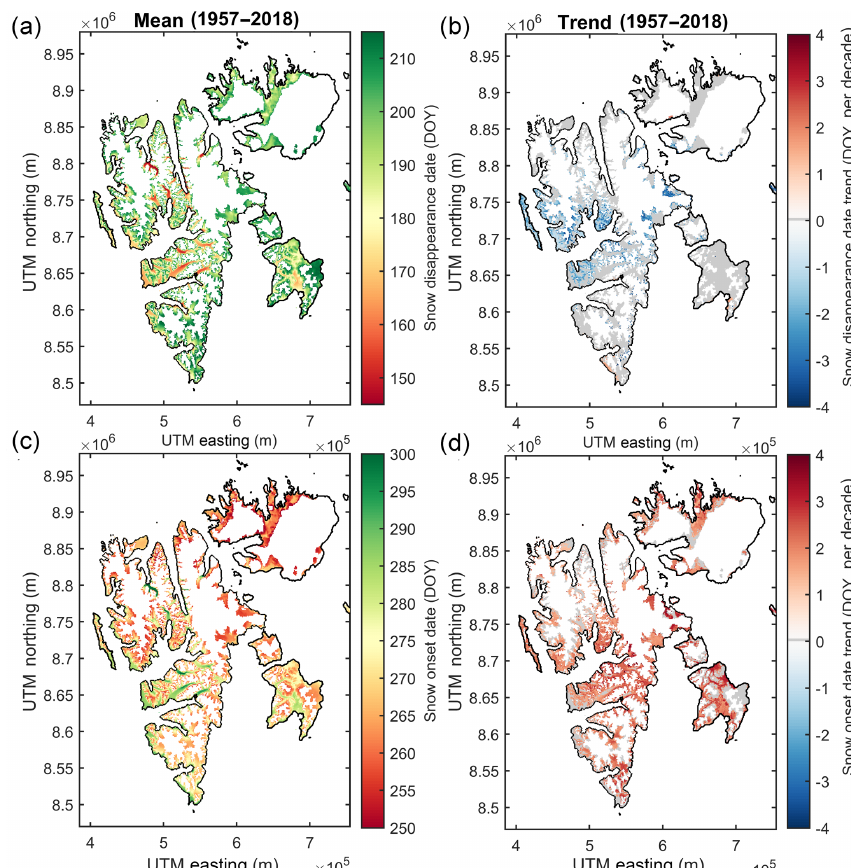
Figure 10. Long-term mean spatial snow disappearance date distribution (a) and trends (b) . Long-term mean spatial mean snow onset date distribution (c) and trends (d) . Snow onset and disappearance dates are only calculated for sites where snow melts completely in summer during at least half of the years in the